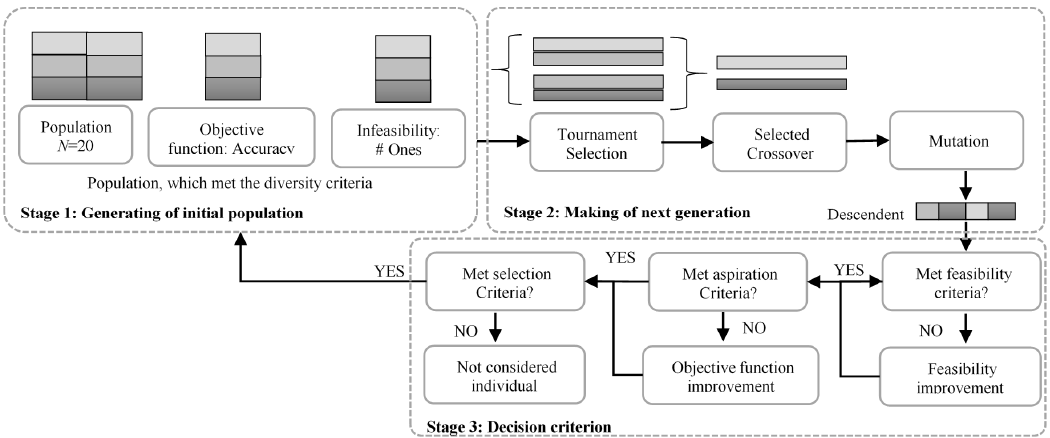
Figure 5. Chu–Beasley algorithm for parametrization and training of ML techniques.